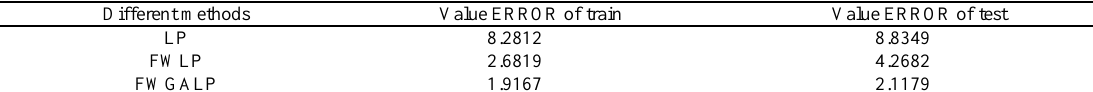
Tables 4. Error results obtained using the different methods for Example 1.